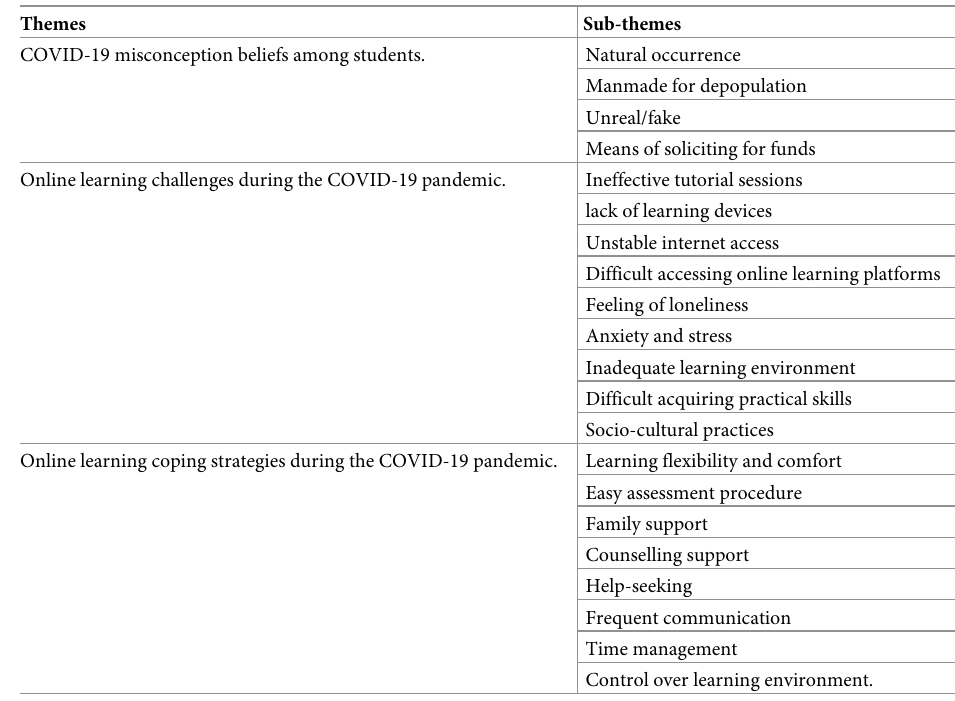
Table 2. Themes and